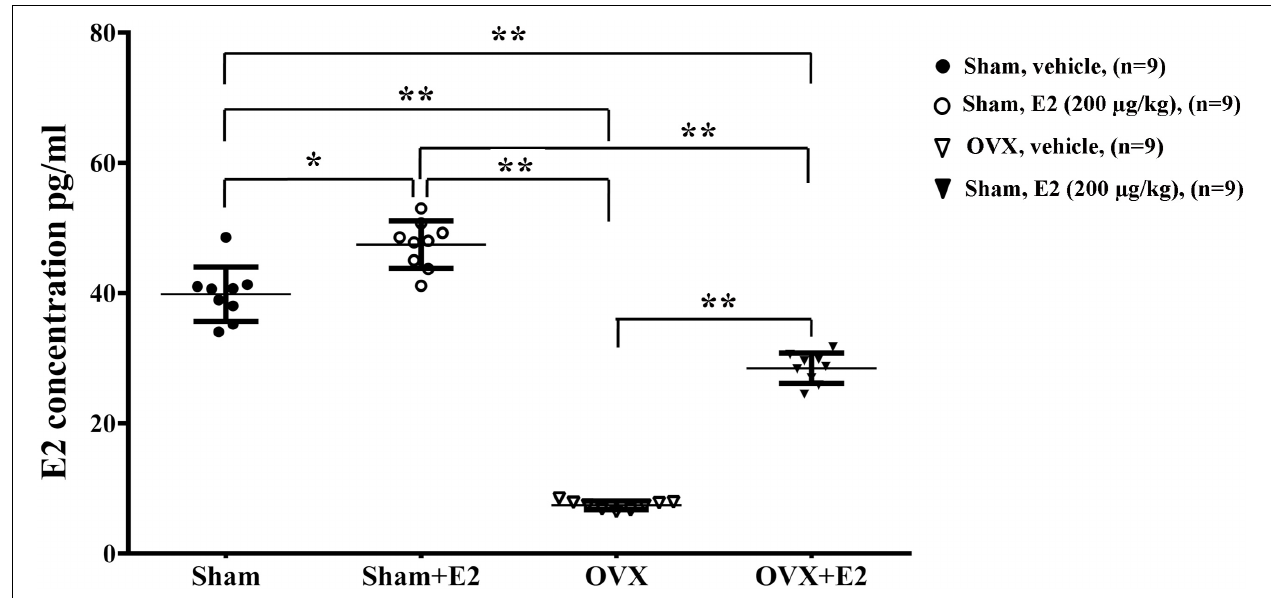
FIGURE 6 | Serum levels of E2 in female rat. Serum was collected 24 h after subcutaneous injection of E2 (0.2 µ g/g) or vehicle (saline) in OVX or sham mice, and measurement of E2 in the serum was conducted by ELISA. ∗ p < 0.05, ∗∗ p < 0.01 versus sham. One-way ANOVA, n = 5 rats per group. All the data are mean ±